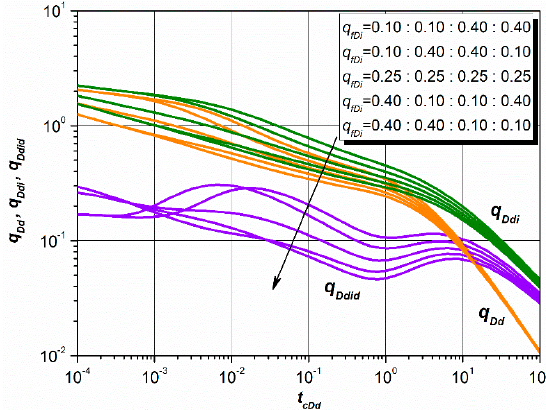
Figure 6. The effect of non-uniform production rate of fractures on combined type curves of an MFHW.